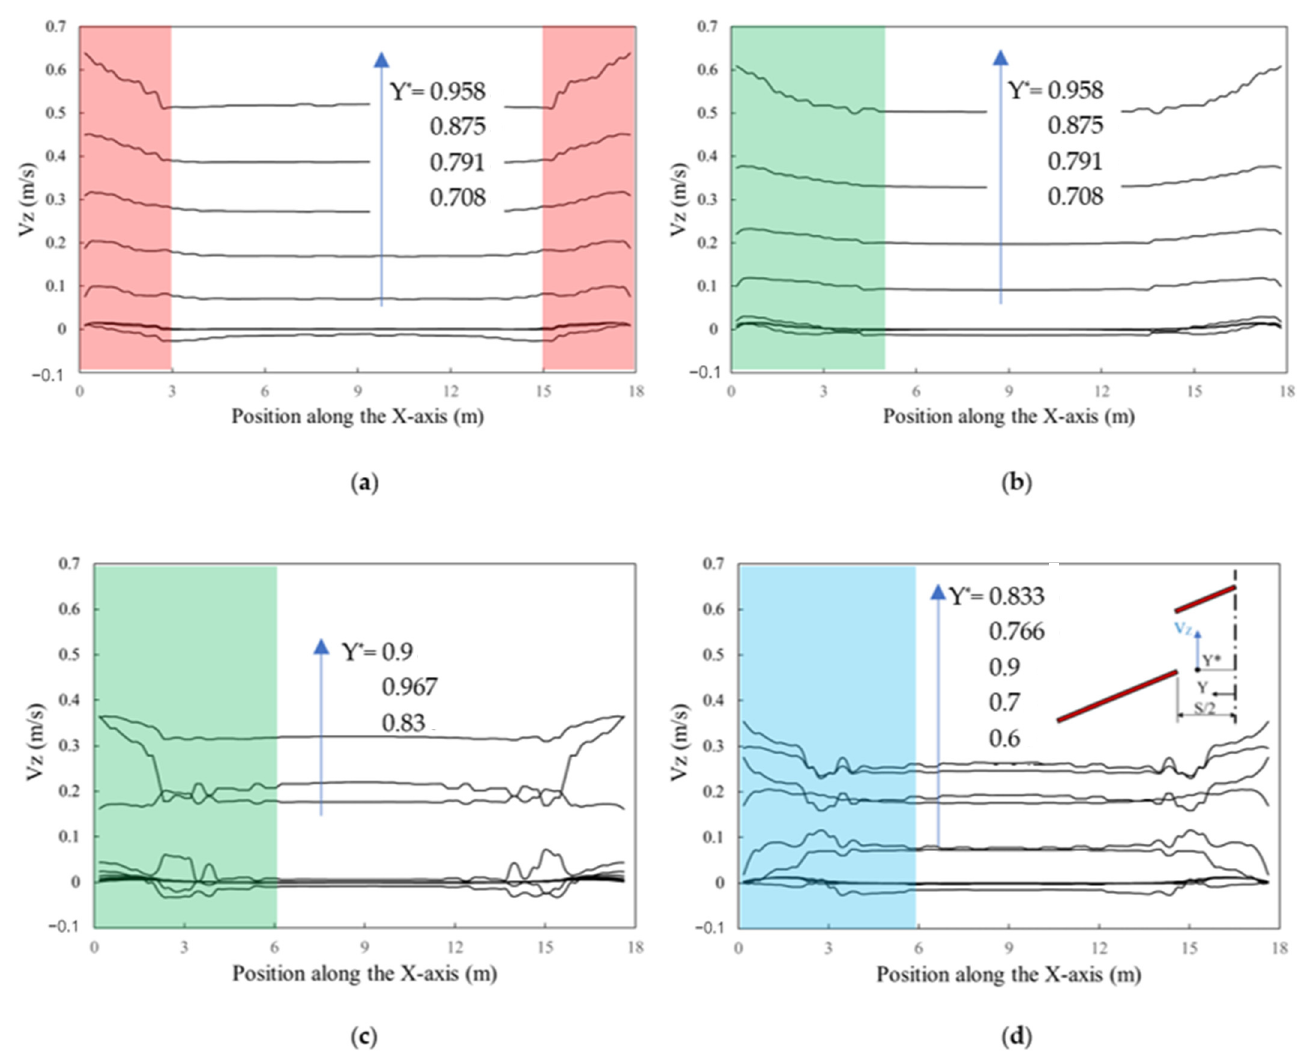
Figure 5. Edge effects. ( a ) S = 1.2 m, H = 0.3 m, E = 0 m; ( b ) S = 1.2 m, H = 0.3 m, E = 0.6 m; ( c ) S = 3 m, H = 0.3 m, E = 0 m; ( d ) S = 3 m, H = 1.2 m, E = 0 m.